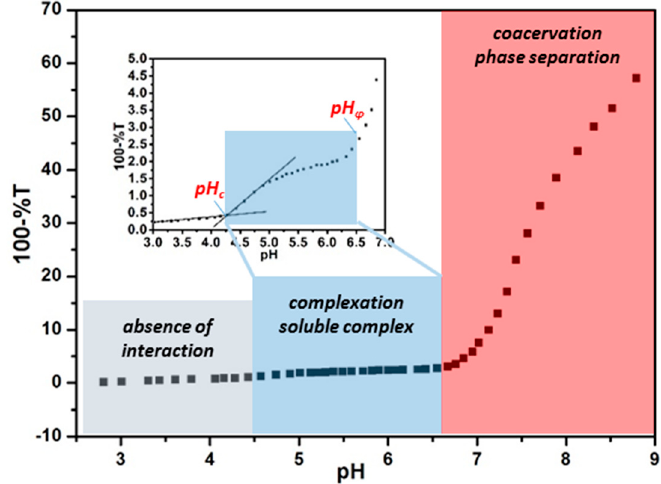
Figure 2. Typical turbidimetric titration curve for bindings between β -lactoglobulin (BLG) and positive charged magnetic nanoparticles at I = 5 mM. Grey, blue, and pink areas indicate the absence of interaction, selective complexation, and coacervation stages, respectively. Inset image is the enlarged local version for identification of the second stage, as well as pH c . The data was taken from the work of [40] and the figure was replotted.